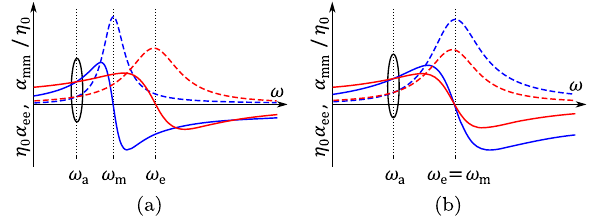
FIG. 2. Illustration of two absorption regimes in a metasurface with unit cells containing electrically and magnetically polar- izable inclusions resonating (a) at different frequencies and (b) at the same frequency. Red and blue lines depict, respectively, normalized electric and magnetic polarizabilities. Solid and dashed lines show the real and imaginary parts of the polar- ¼ izabilities, respectively. Calculation parameters: (a) ω m ¼ 1 . 28 ω 2 ¼ 1 , γ ¼ 0 . 2 ω ¼ 0 . 1 ω ¼ 0 . 86 ω , A , A , γ , ω e e m e e m m a e ¼ ω ¼ ω 2 ¼ 1 . 56 , γ ¼ 0 . 2 ω 0 . 74 ω ; (b) ω , A , A , e e e m e m e e γ ¼ 0 . 2 ω ¼ 0 . 8 ω , ω m m a e